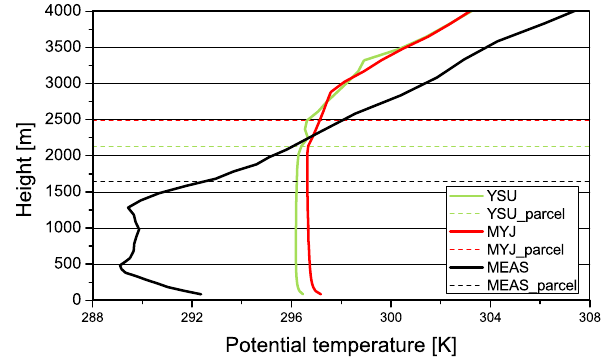
Figure 5. Simulated turbulent kinetic energy (MYJ) and calculated bulk Richardson number (YSU) profile and simulated PBL heights (dashed lines) on 17 July 2012 at 12 UTC.